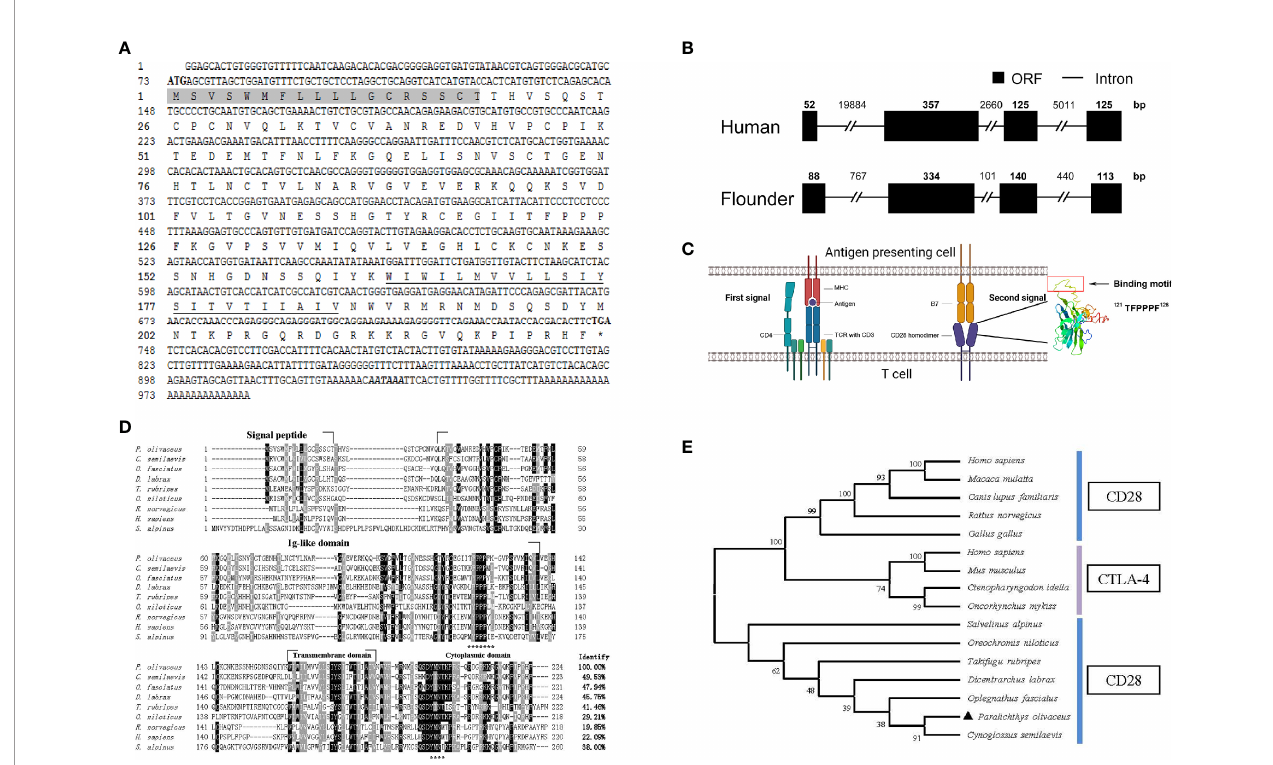
FIGURE 1 | Cloning the CD28 gene and bioinformatics analysis of deduced amino acid sequence in fl ounder. (A) The cDNA sequence and deduced amino acid of CD28 . The signal peptide is shadowed, and the transmembrane domain is underlined. The asterisk indicates the stop codon. Putative polyadenylation signal ( AATAAA ) is in bold italic. (B) Comparison of the intron/ORF structures of the CD28 gene of human and fl ounder. ORF and introns are shown with black boxes and lines, respectively. The sizes of the intron/ORF are indicated by the number above. (C) Schematic diagram of the two-signaling pattern of T cell activation and tertiary structure of the extracellular domain of CD28 molecule. (D) Multiple alignments of CD28 protein homologs. The residues that are ≥ 75% identical among the aligned sequences are in black. The conversed motifs are indicated with asterisks below the alignment. The dashes in the amino acid sequences indicate gaps introduced to maximize alignment. (E) Phylogenetic trees of CD28 and CTLA-4 molecules homologs. The unrooted phylogenetic trees are constructed by the neighbor-joining method based on the amino acid alignment (Clustal W) of full-length protein sequences. Numbers in each branch indicate the percentage bootstrap values on 1,000 replicates. The accession numbers used in Figure S3 are listed in Supplementary Materials